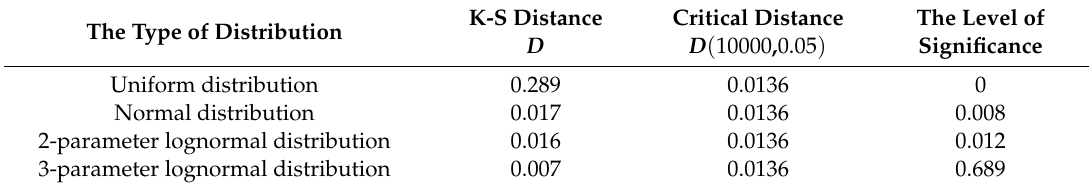
Table 4. The results of the K-S